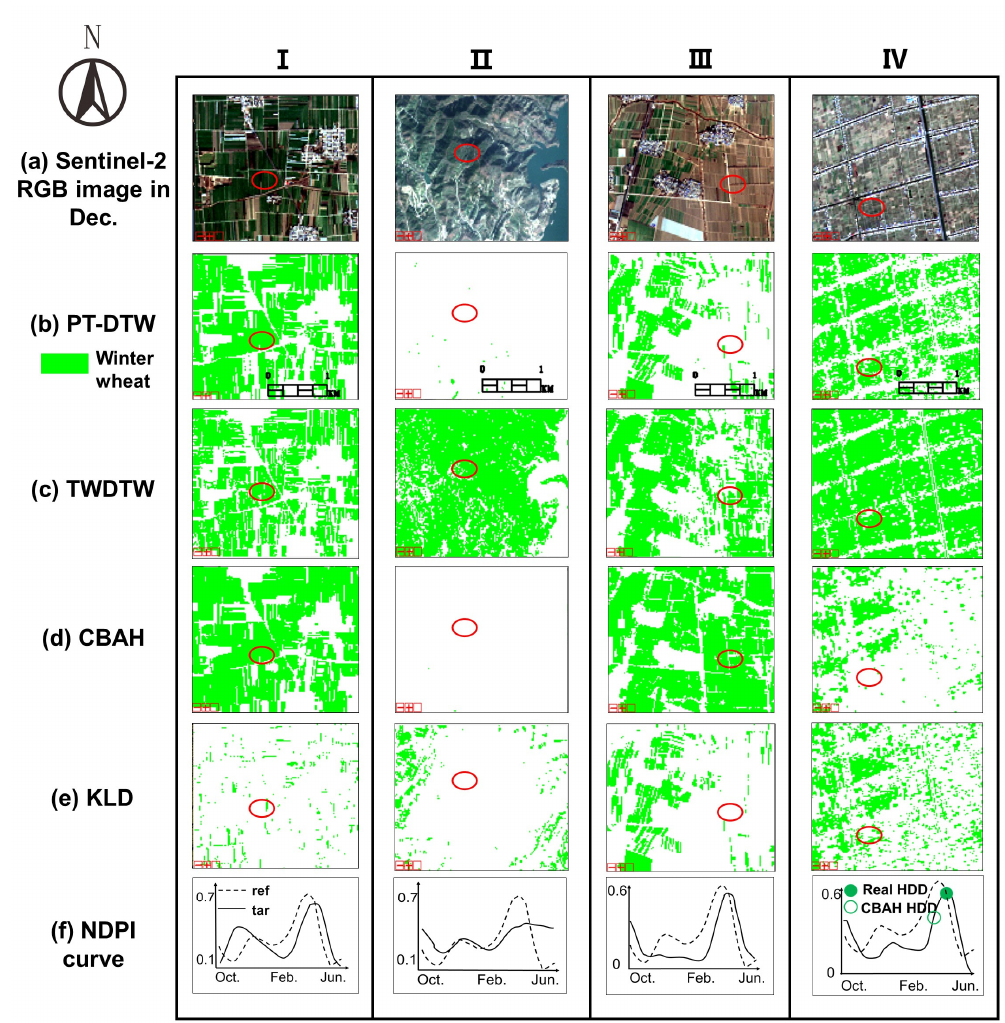
Figure 12. Comparison of spatial details of four example locations, location I (38.6508 ◦ N, 115.2872 ◦ E), II (32.5539 ◦ N, 111.0283 ◦ E), III (37.8897 ◦ N, 115.4178 ◦ E), and IV (33.5343 ◦ N,120.2 565 ◦ E). ( a ) Sentinel-2 RGB composite images in December. Winter wheat maps derived using the ( b ) PT-DTW method, ( c ) TWDTW method, ( d ) CBAH method, and ( e ) KLD method. ( f ) NDPI curves of pixels in the target(tar) regions denoting by red circles and the reference(ref) curve used in PT-DTW method. In the NDPI curve of site IV, the filled and unfilled green circle indicates the real heading date (Real HDD) and the CBAH method estimated heading date (CBAH HDD).